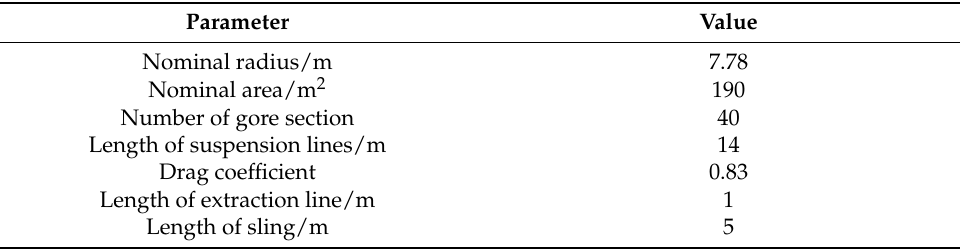
Table 1. Main parameters of